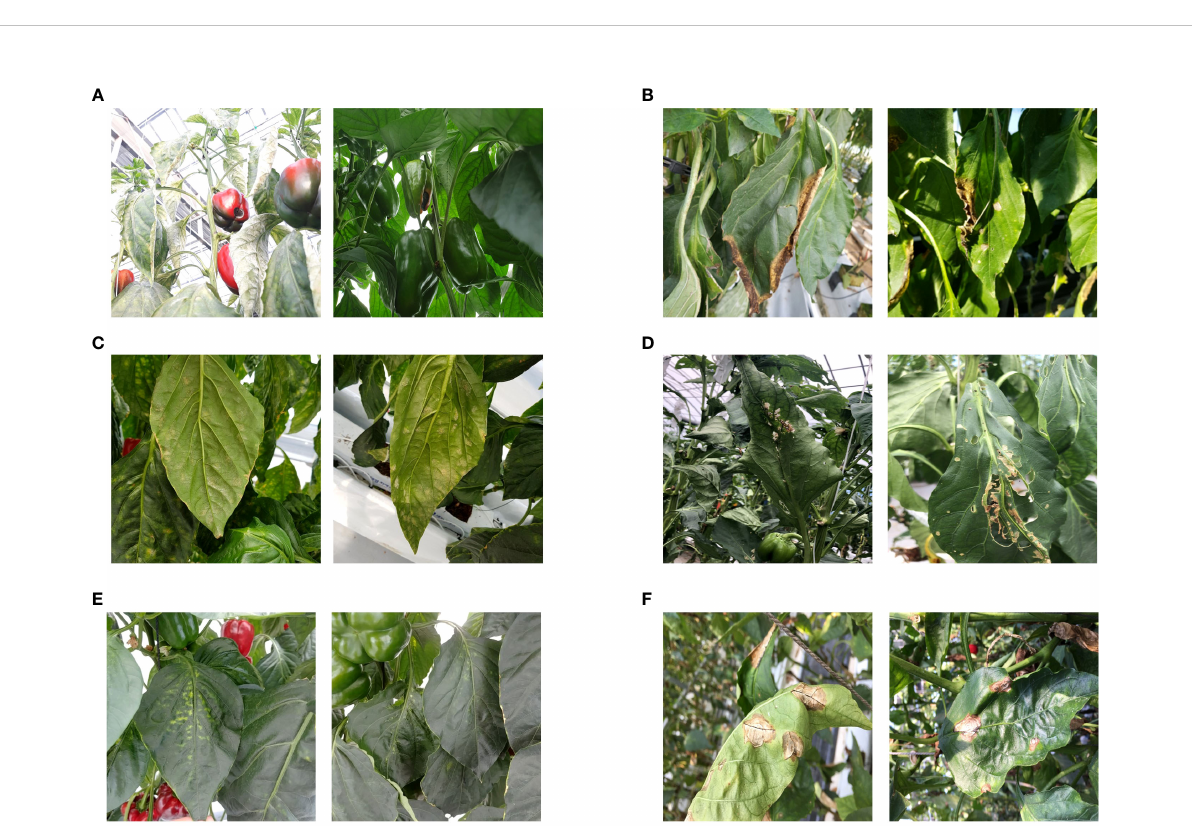
FIGURE 2 Representative instances of each class (A) blossom end rot, (B) gray mold, (C) powdery mildew, (D) snails and slugs, (E) spider mite, and (F) Cercospora .